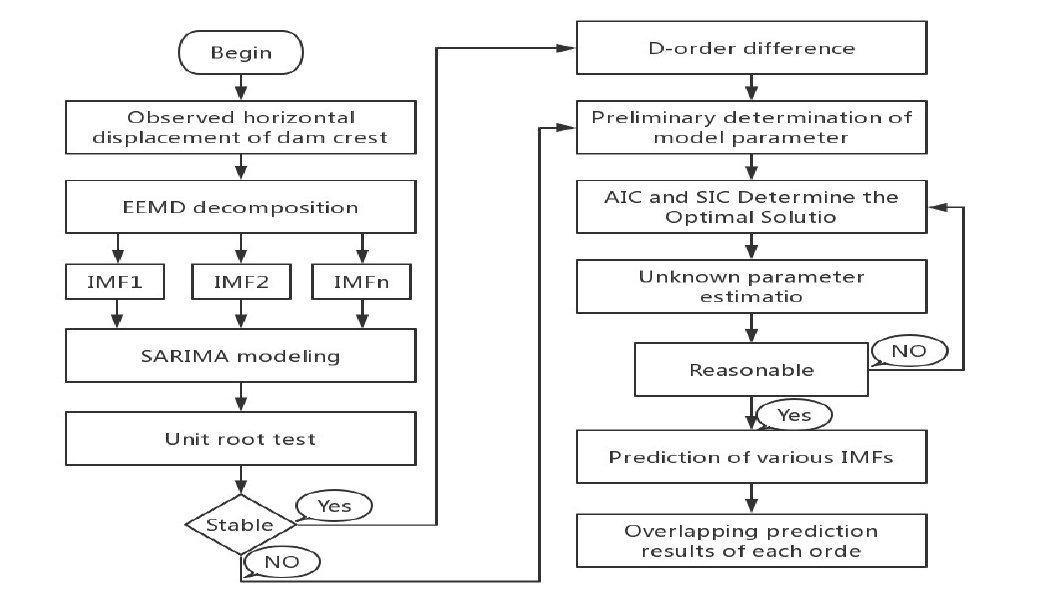
Figure.1 EEMD-SARIMA model flow chart